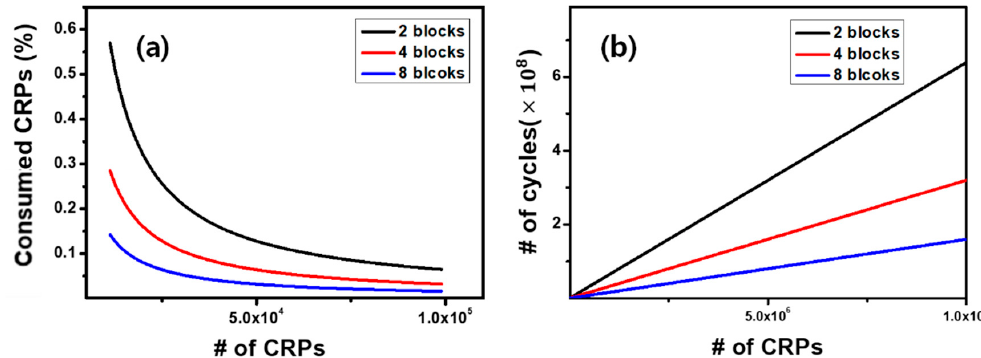
Figure 7. ( a ) The percentage of consumed CRPs; and ( b ) the number of cycles required according to the increasing number of CRPs.